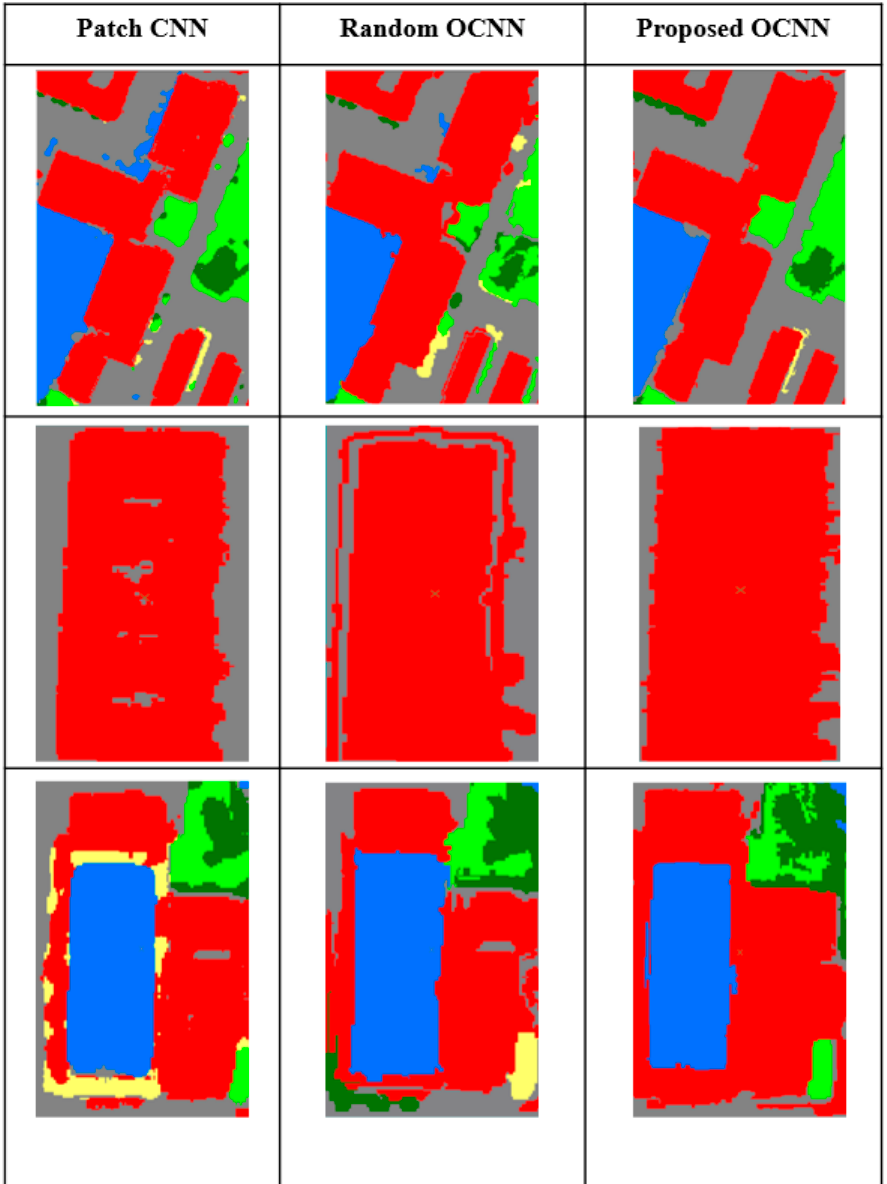
Figure 13. The improved land-cover extraction depending on the proposed OCNN method compared to traditional methods.